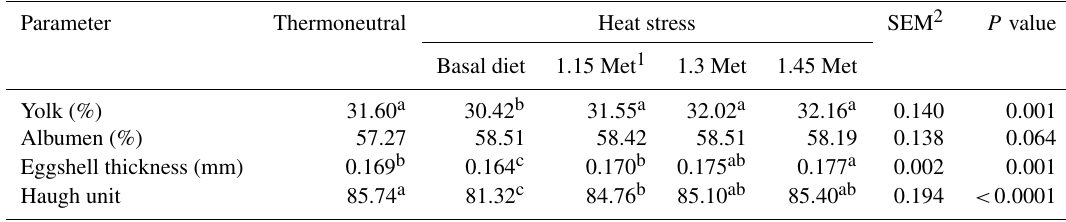
Table 3. Effect of methionine on yolk and albumen percentage, shell thickness and Haugh unit in breeder quails.